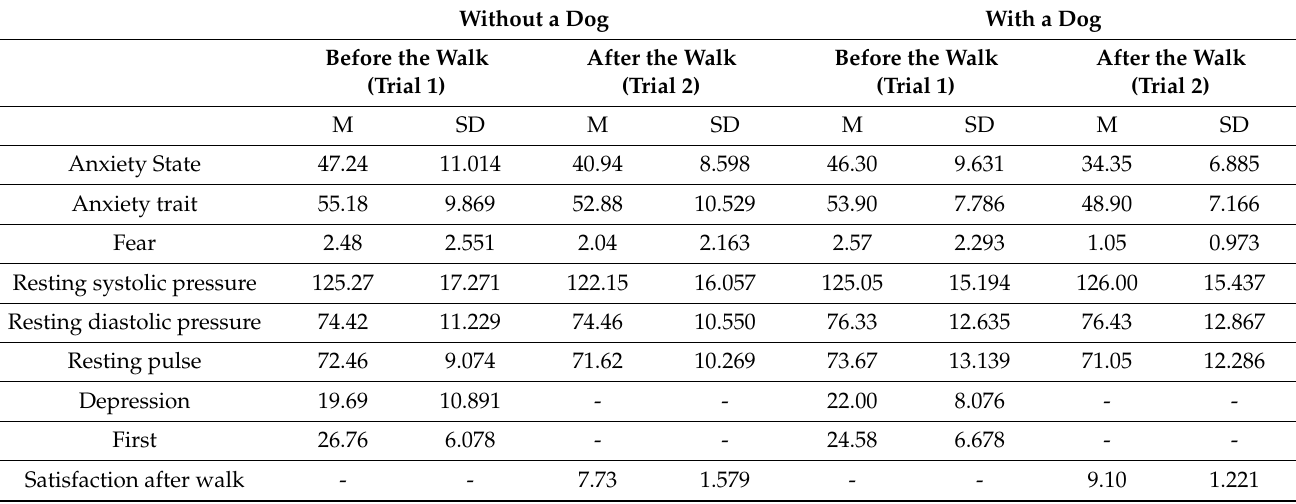
Table 1. Descriptive statistics for group 1 and 2. Note. M—mean; SD—standard deviation. Without a Dog With a Dog Before the Walk After the Walk Before the Walk After the Walk (Trial 1) (Trial 2) (Trial 1) (Trial